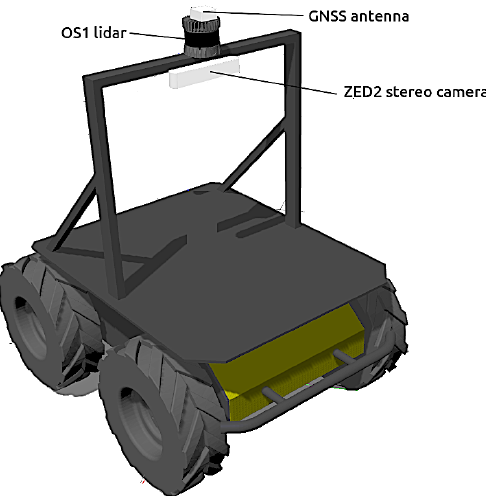
Figure 2. Model of Husky in Gazebo with a stand for its exteroceptive